Question: What kind of plot is shown here?
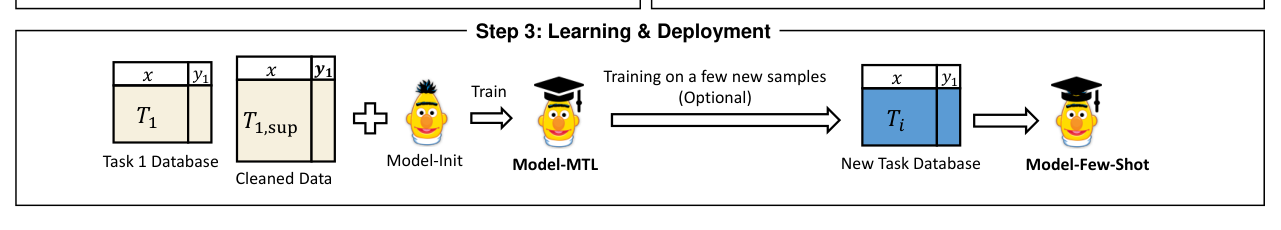
Answer: line